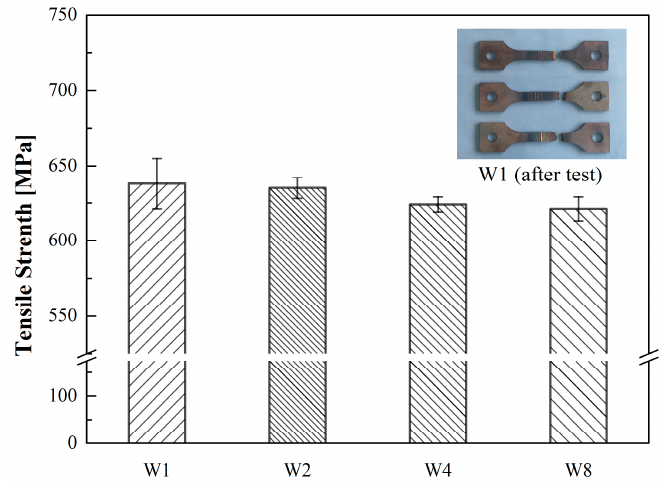
Figure 9. Tensile strength of welded TC31 specimens by laser oscillating welding method at 923 K. (The inset show the photograph of the W1 joint after the high-temperature tensile test.).